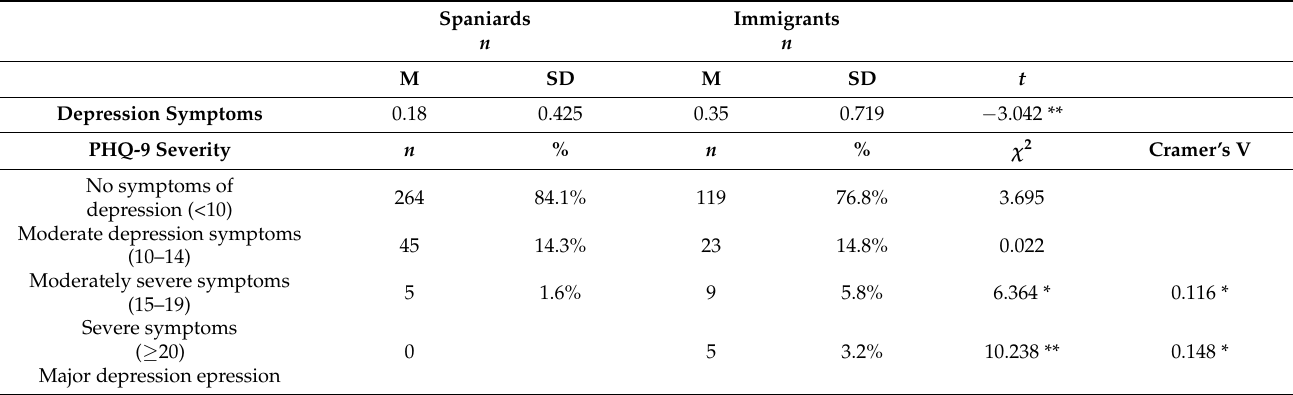
Table 2. Differences in severity of symptoms if they are Spaniards or